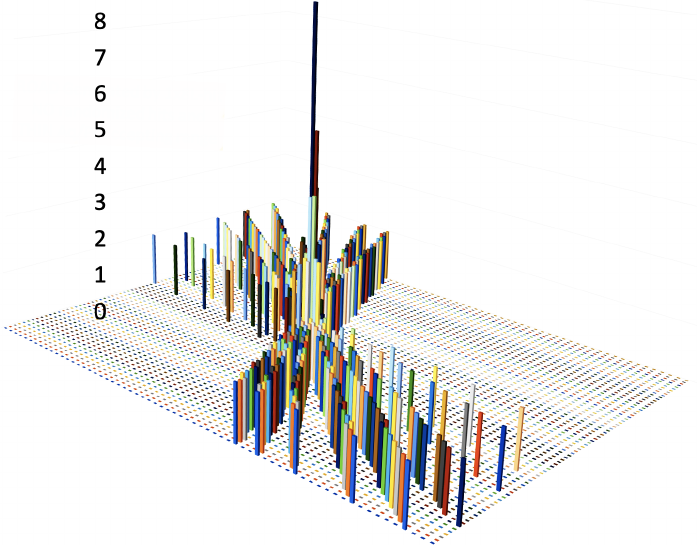
Figure 3. 3D plot representation of the HS with a unique 8 high bin: the identified